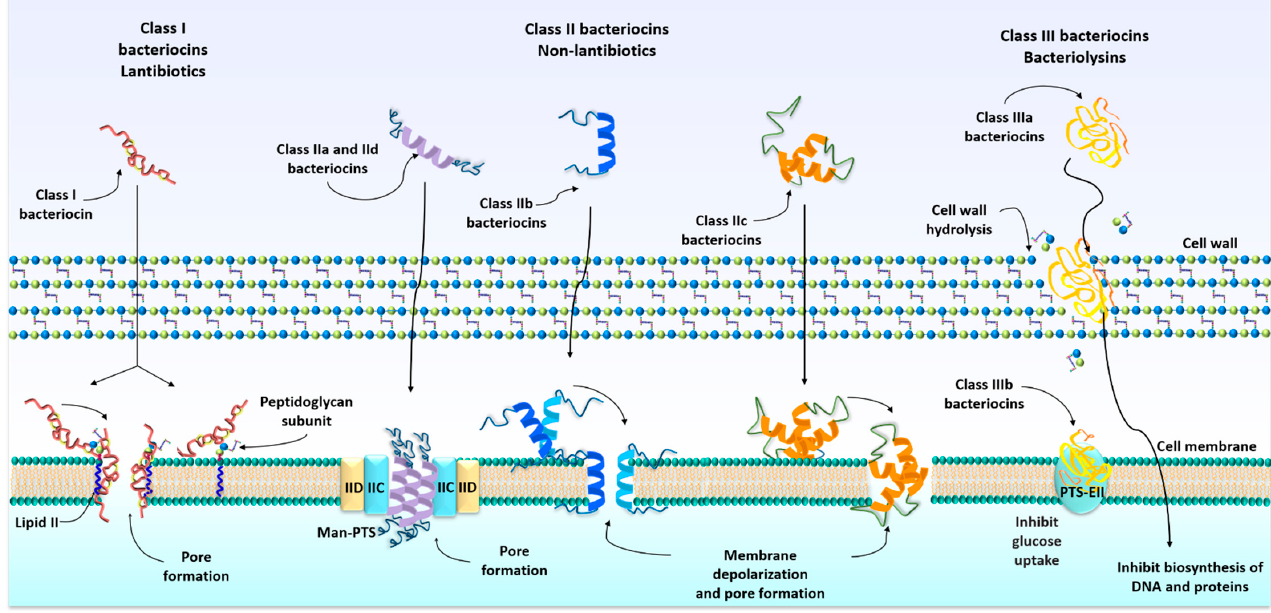
Figure 1. Mode action of bacteriocins. Bacteriocins act directly on the membrane or through a specific receptor on the target cell and form pores in the bacterial cell membrane, which leads to cell death.